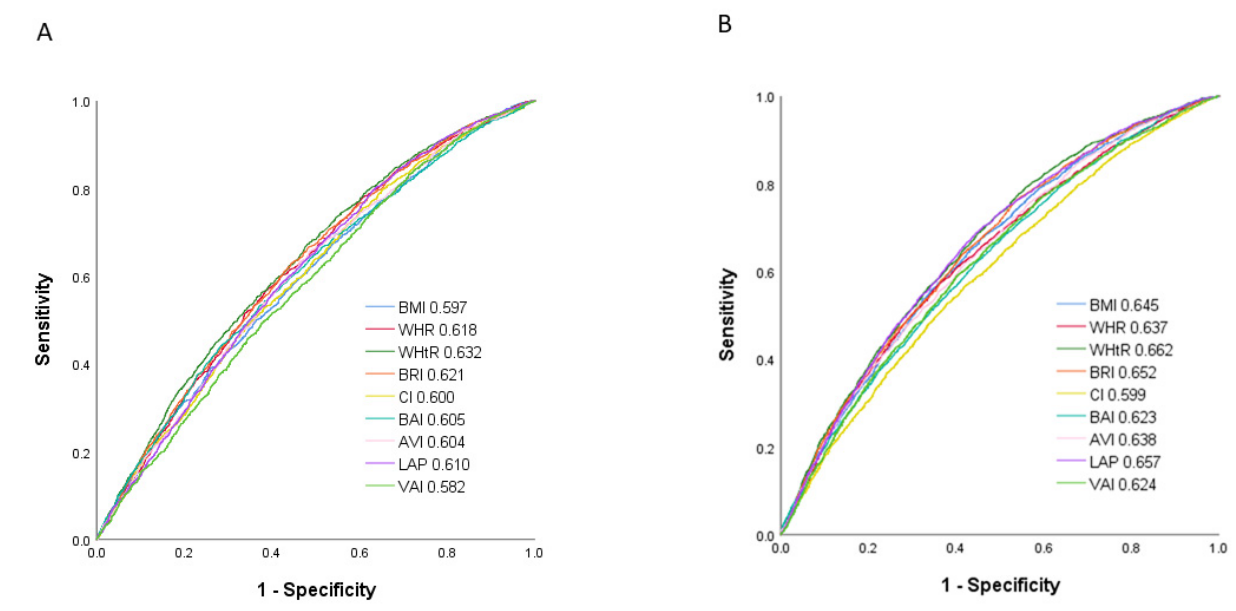
Figure 2. Comparison of the predictive value of nine obesity-related indices for diagnosis of incident hypertension among ( A ) males and ( B ) females. Table 7. Area under curve (AUC), cutoff value, sensitivity, specificity, and Youden index of nine obesity-related indices in female